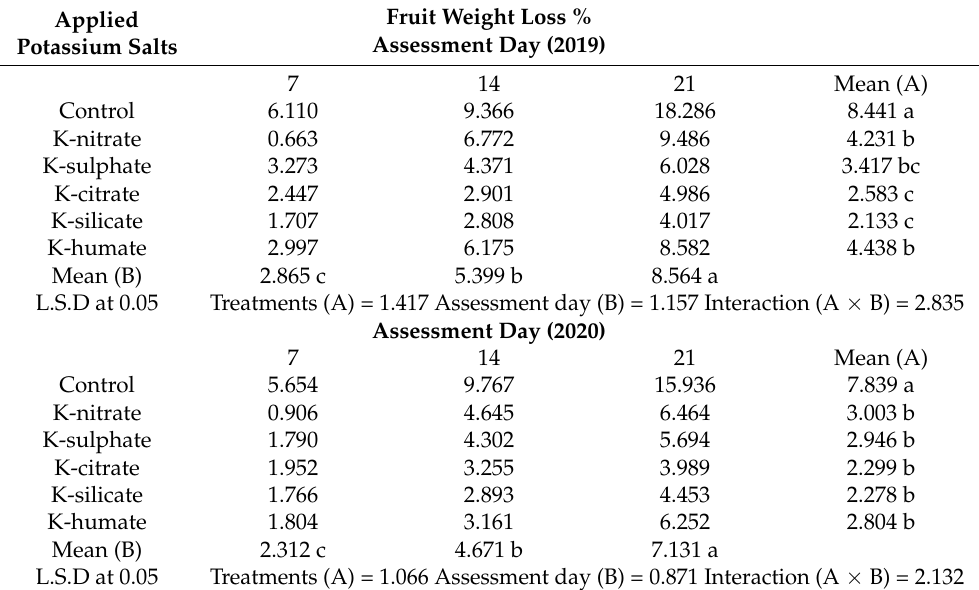
Table 3. Effect of diverse potassium sources as foliar application on weight loss % of apricot fruits